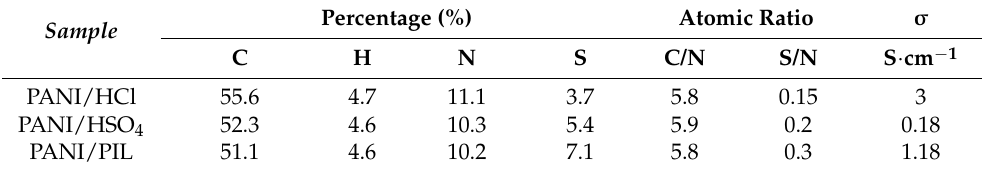
Table 2. Elemental composition and electrical conductivity ( σ ) of the investigated PANI.